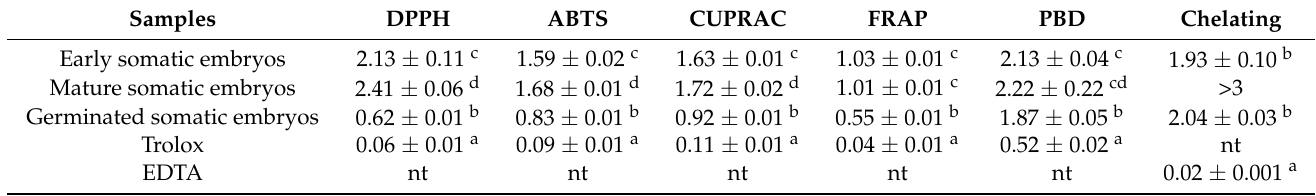
Table 5. Antioxidant properties of the tested samples (IC 50 (mg